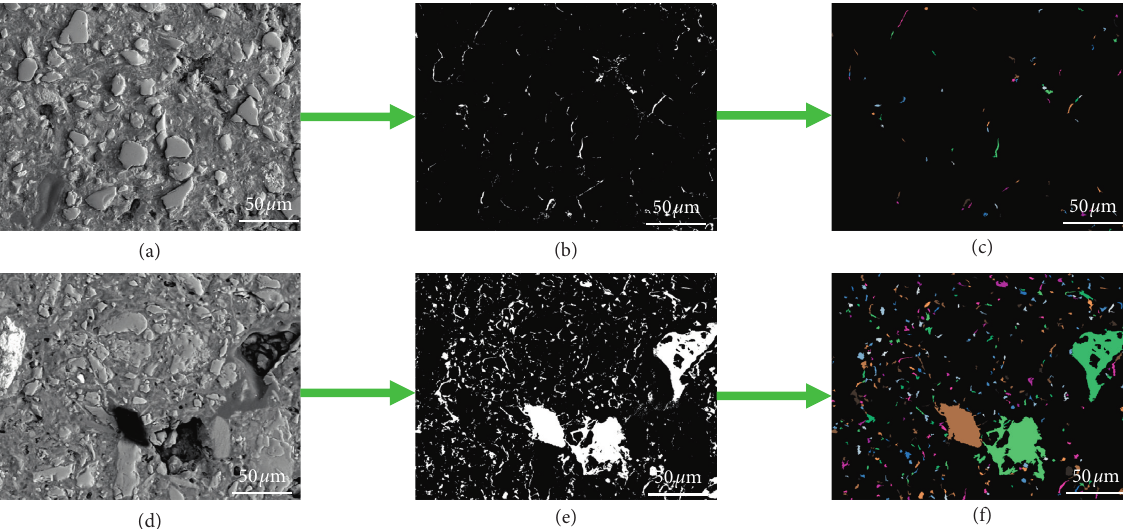
Figure 10: Binarization and pore extraction of microscopic images of loess specimens. SEM images of undisturbed loess: (a) original, (b) with binary image processing, and (c) with vectorization. SEM images of acid-etched loess: (d) original, (e) with binary image processing, and (f) with vectorization.